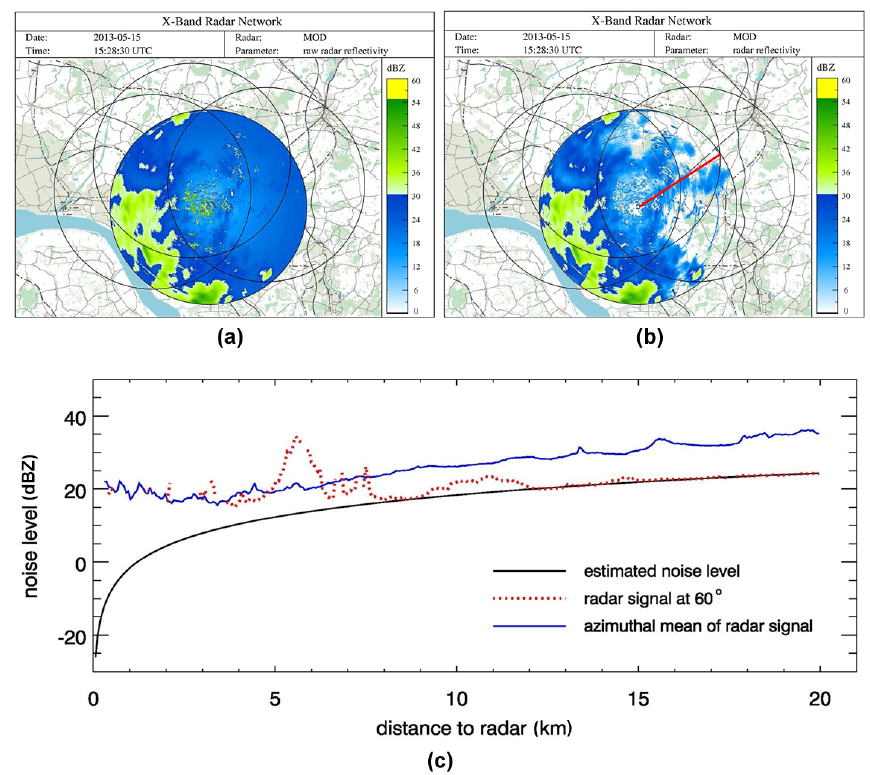
Figure 3. Estimating noise level for radar MOD for 15 May 2013, 15:28:30UTC: (a) raw reflectivity field, (b) reflectivity field without background noise, with the red line indicating a 60 ◦ azimuth, and (c) noise level and radar signal as a function of the distance to the